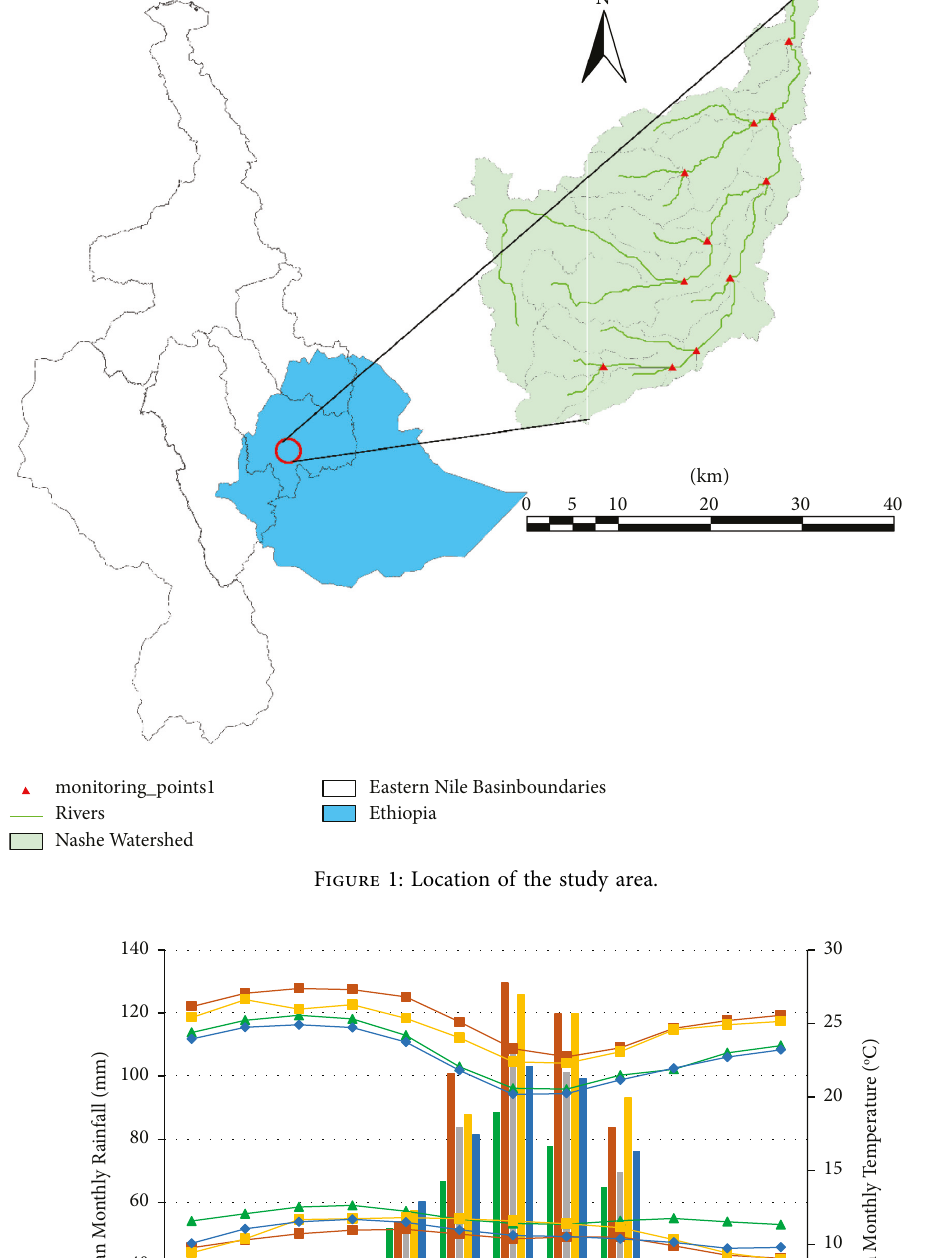
Figure 1: Location of the study area.